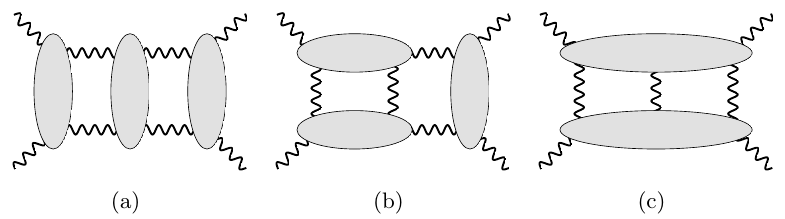
Figure 3 . The three two-loop spanning cuts involving only pure N = 2 states. All exposed propagators are understood as being taken on